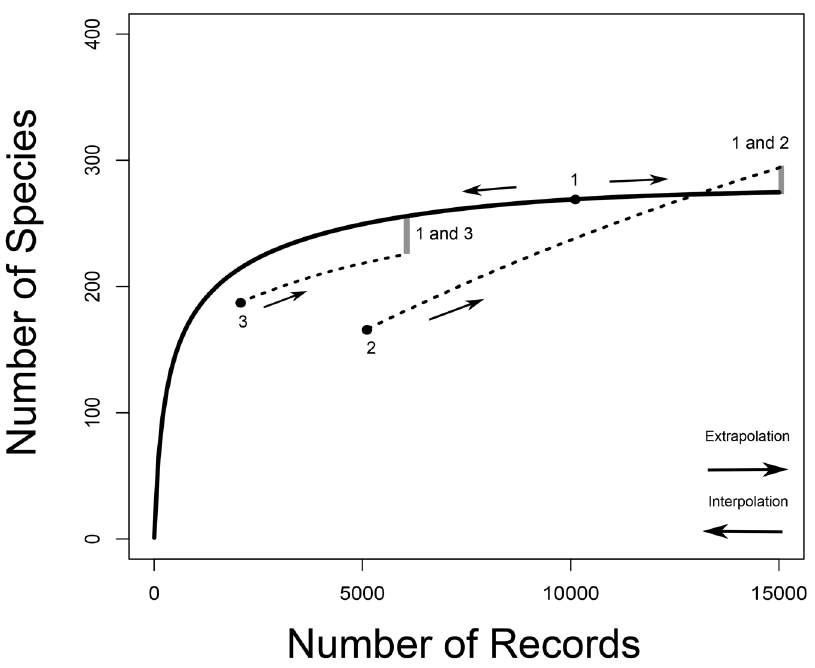
Figure 1. Species accumulation curves. Species richness is the asymptote of a species accumulation curve, which expresses the dependence on sampling effort of the number of species sampled from an assemblage. In CA2013, sampling effort is given by the number of records from which the number of species is calculated. For illustrative purposes, an example with three arbitrary samples (for 10000, 5000 and 2000 records, labeled from one to three) is drawn. For sample one, a predicted species accumulation curve is added that gradually increases from one species sampled to the predicted species richness for that assemblage (full line). Such curves are constructed on the basis of interpolation and extrapolation. For samples two and three only segments of extrapolated curves are drawn (dotted lines). For sample two, a curve that crosses the species accumulation curve of sample one is sketched. For samples one and three species accumulation curves are more or less proportional. The way in which the species richness differ- ences between samples are assessed in CA2013 is illustrated by indicating on the species accumulation curves at which numbers of records pairwise comparisons would be made between two sample pairs (1 vs. 2 and 1 vs. 3). The number of species of the sample with the smallest number of records is extrapolated to the number expected at three times the number of records. When the number of records of the other sample is still larger than that, the number of species of the second sample is interpolated (rarefied), oth- erwise it is extrapolated as